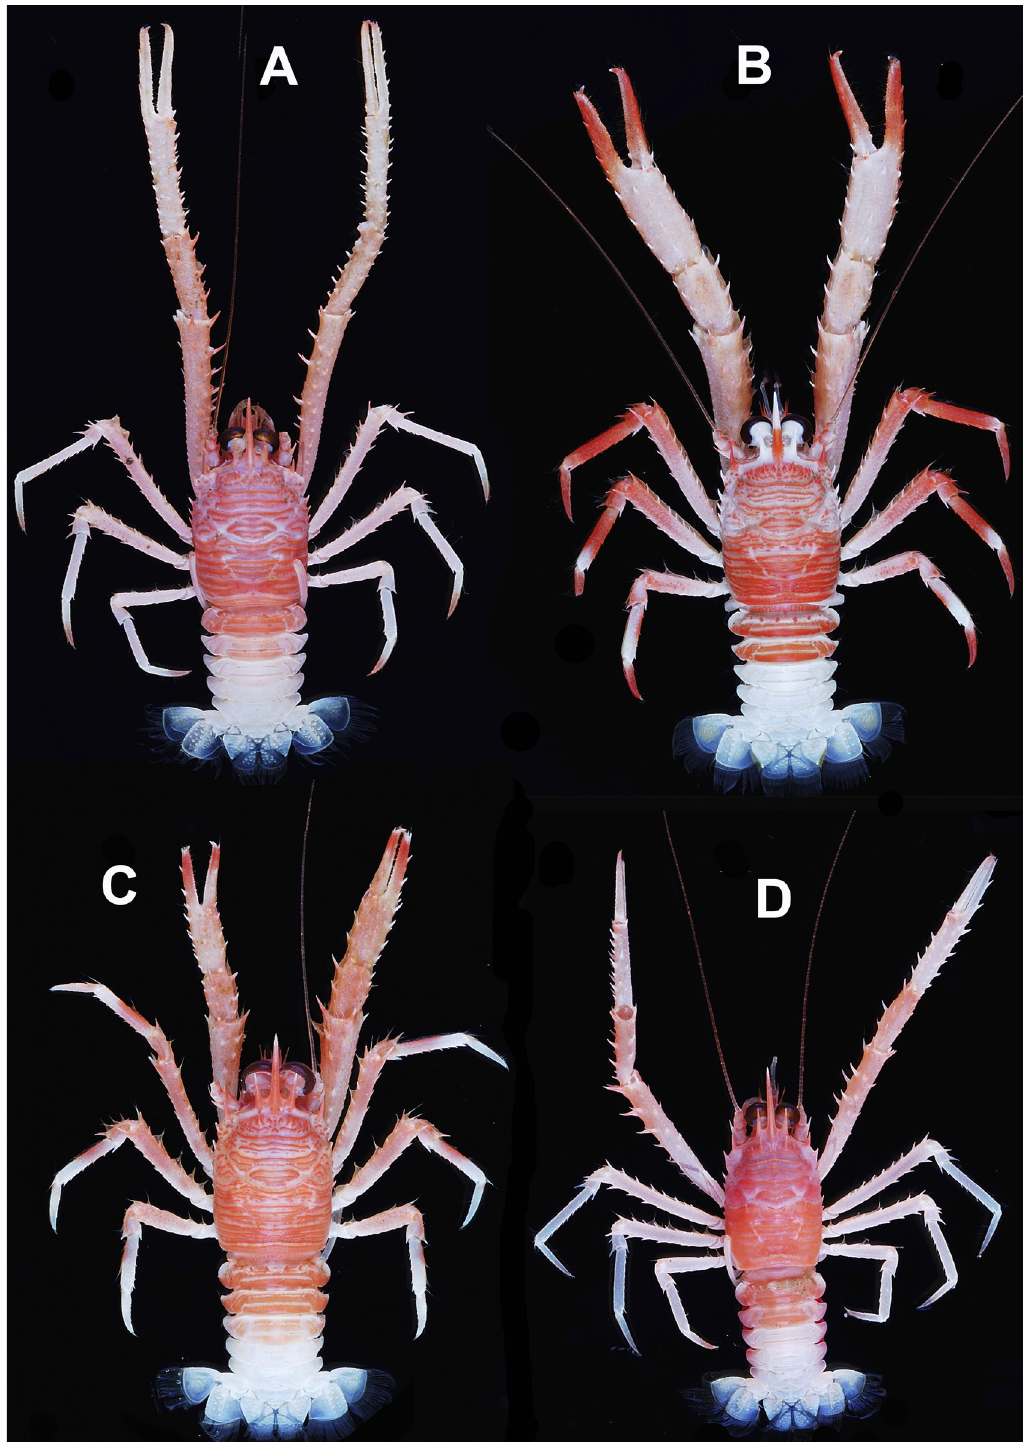
Fig. 11. Dorsal view. Colours in life. A . Munida africana Balss, 1913, ♀, 10.9 mm, Mozambique, MAINBAZA, Stn CP3141. B . Munida benguela de Saint-Laurent & Macpherson, 1988, ♂, 20.0 mm, Mozambique, MAINBAZA, Stn CP3138. C . Munida benguela de Saint-Laurent & Macpherson, 1988, ♀, 13.7 mm, Mozambique, MAINBAZA, Stn CP3135. D . Munida hoda sp. nov., paratype, ov. ♀, 11.4 mm, Mozambique, MAINBAZA, Stn